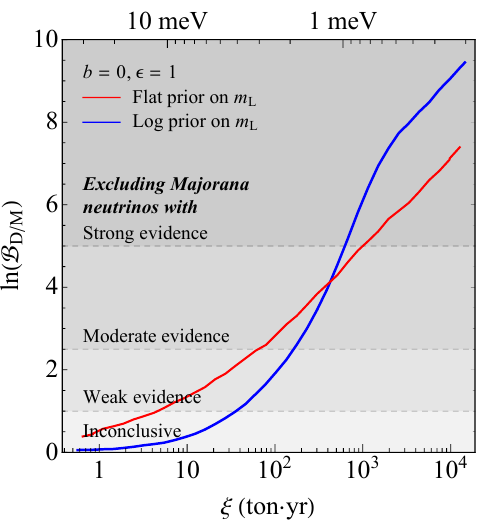
) , which reflects the odds of Dirac neutrinos over Majorana Figure 4 . The Bayesian factor ln( B D / M ones, for different values of the exposure ξ with a vanishing background and a full efficiency (cid:15) = 1 . Null signal in future 0 νββ -decay experiments is assumed. The top horizontal axis signifies the corresponding 3 σ sensitivities to | m | with the average NME of |M | = 2 . 94 for 136 Xe 0 ν ββ